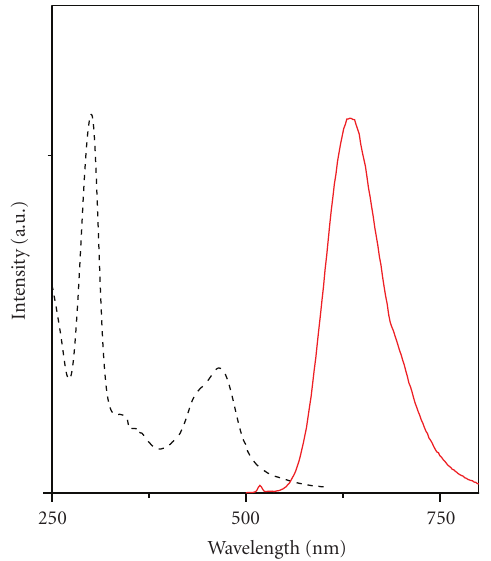
Figure 2: Normalized absorption and emission spectra of complex ( 1 ). The emission spectra were excited at 450nm.